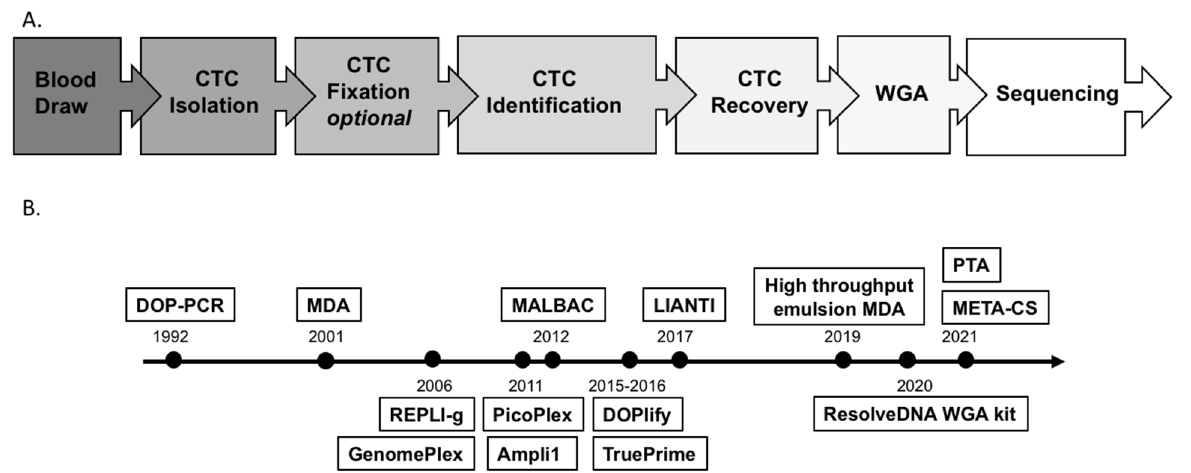
Figure 1. ( A ) Workflow of single-CTC analysis. ( B ) Timeline of WGA technology development.